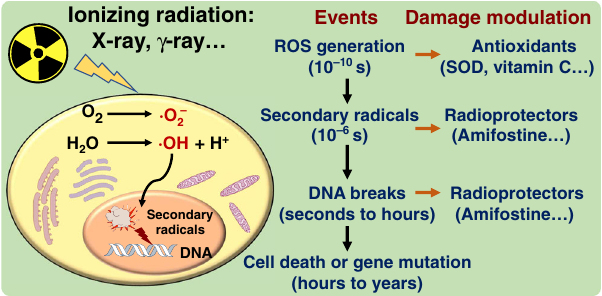
Fig. 4 Radiation and radioprotectors. Events after radiation exposure and possible damage modulation by